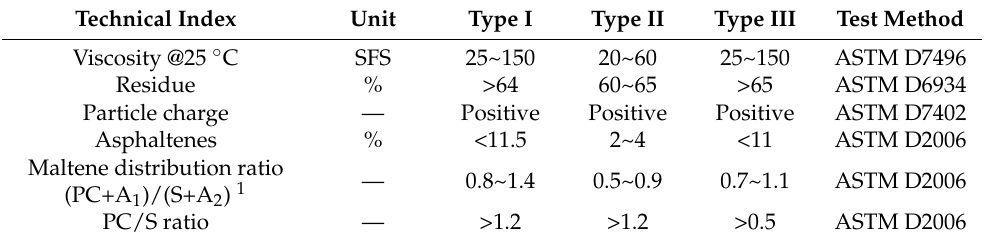
Table 2. Technical indices of the